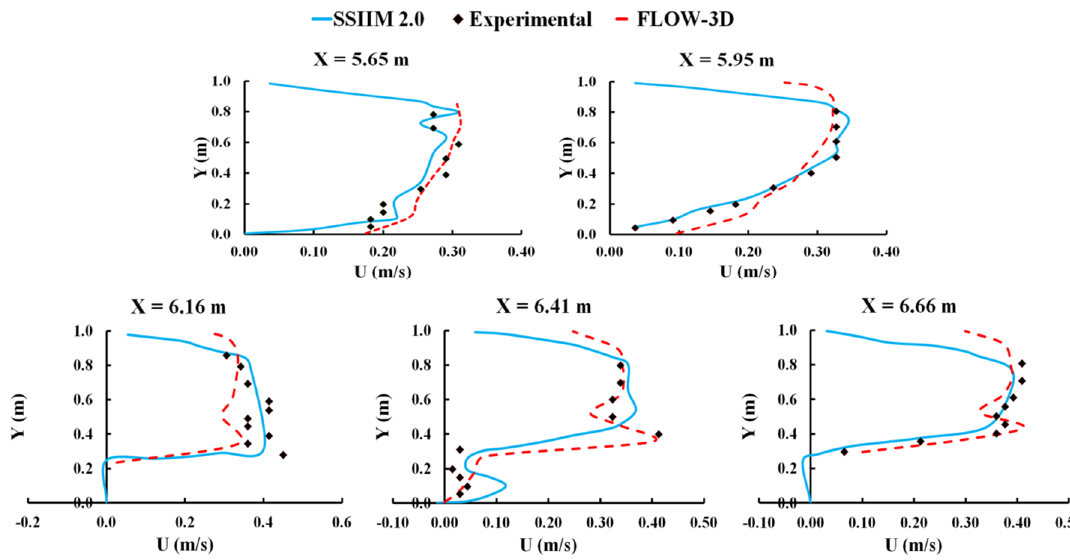
Figure 3. Velocity in horizontal sections; z = 2 cm, x = 5.65, 5.95, 6.16, 6.41, and 6.66m. Table 3. Comparison of simulated absolute velocity in Computational Fluid Dynamics (CFD) simulation and experimental data. Cross Section FLOW-3D SSIIM 2.0